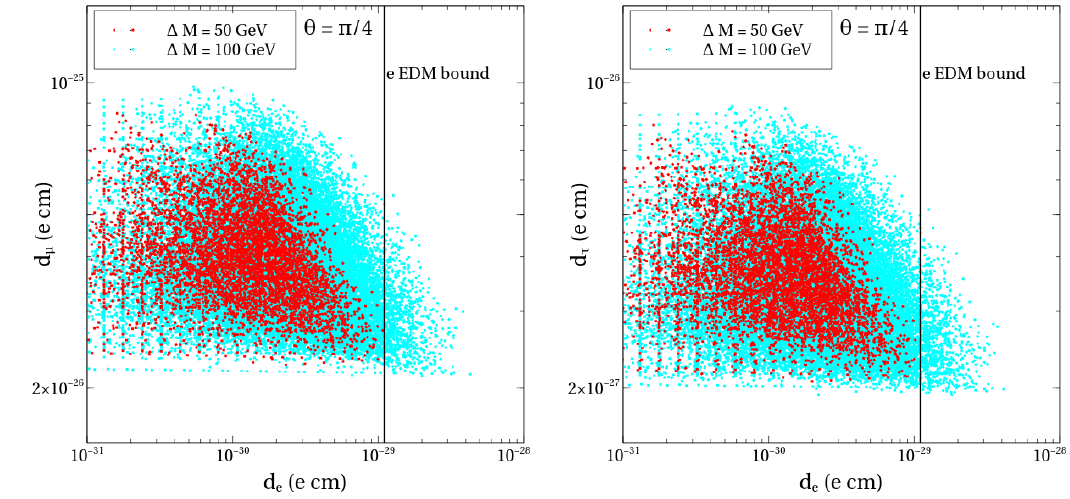
Figure 15 . Scatter points maintaining (cid:1) a (cid:22) within its 2 (cid:27) range and BR (cid:28) ! (cid:22) (cid:22)ee within the quoted limit plotted in the d e d (cid:22) (left) and d e d (cid:28) (right) planes. A normal neutrino mass hierarchy is (cid:0) (cid:0) assumed. The color coding is explained in the legends. The region to the right of the vertical black line is disallowed by the electron EDM upper